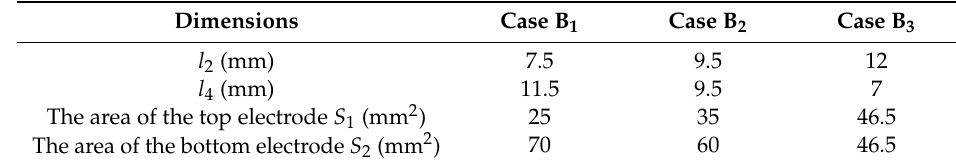
Table 3. Piezoelectric receiver with two pairs of non-rectangular